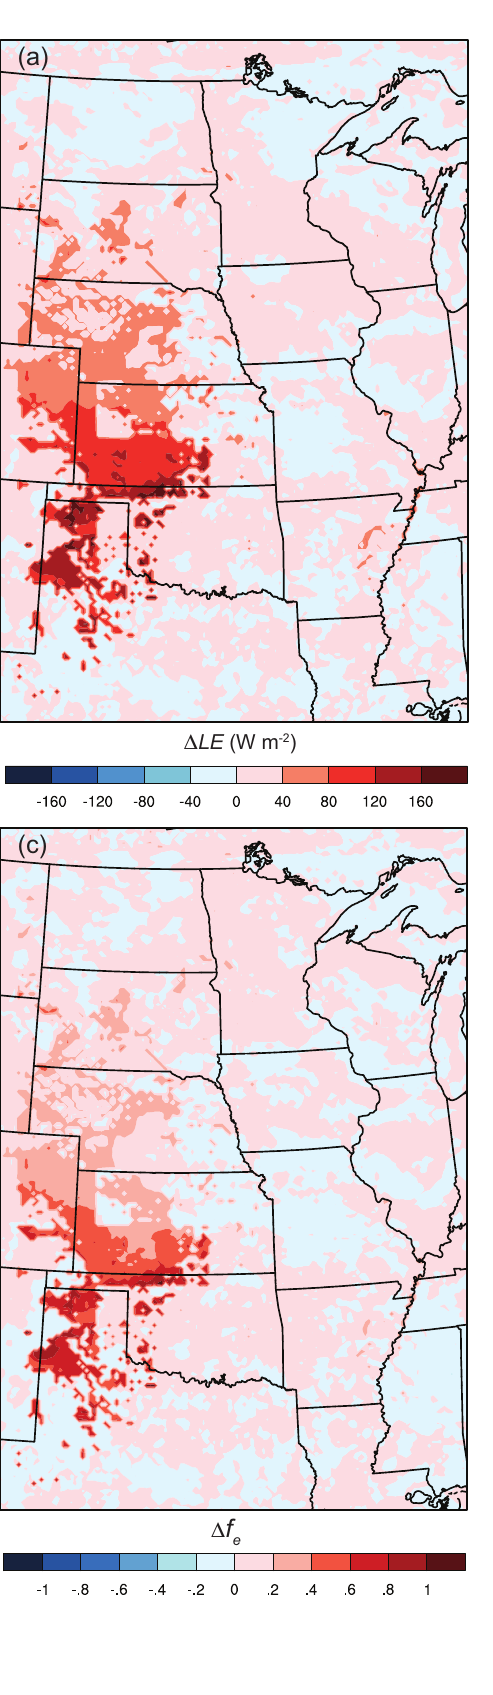
Figure 4. Differences in monthly-mean quantities between IRR (irrigated) and CTL (non-irrigated) simulations for the month of July. ( a ) Latent heat flux; ( b ) Sensible heat flux; ( c ) Evaporative fraction; ( d ) Percent difference in IRR net radiation with respect to the CTL